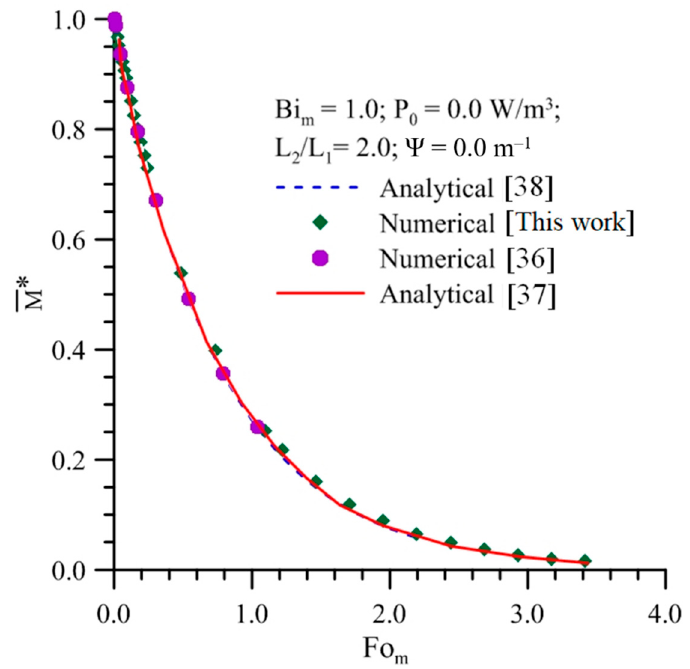
Figure 4. Comparison between the predicted and analytical moisture ratio as a function of the time for convective drying of a prolate spheroidal solid.